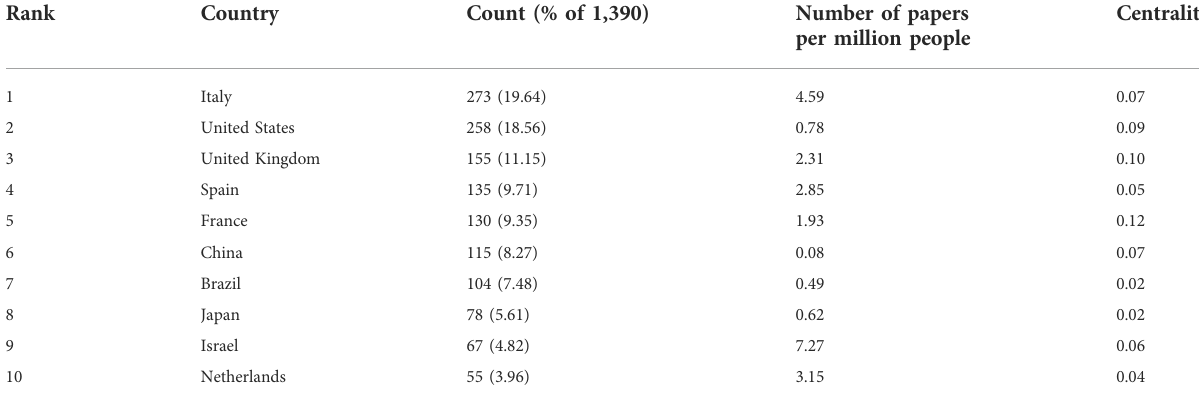
TABLE 1 Top 10 countries with the highest productivity related to antiphospholipid syndrome (APS). Rank Country Count (% of